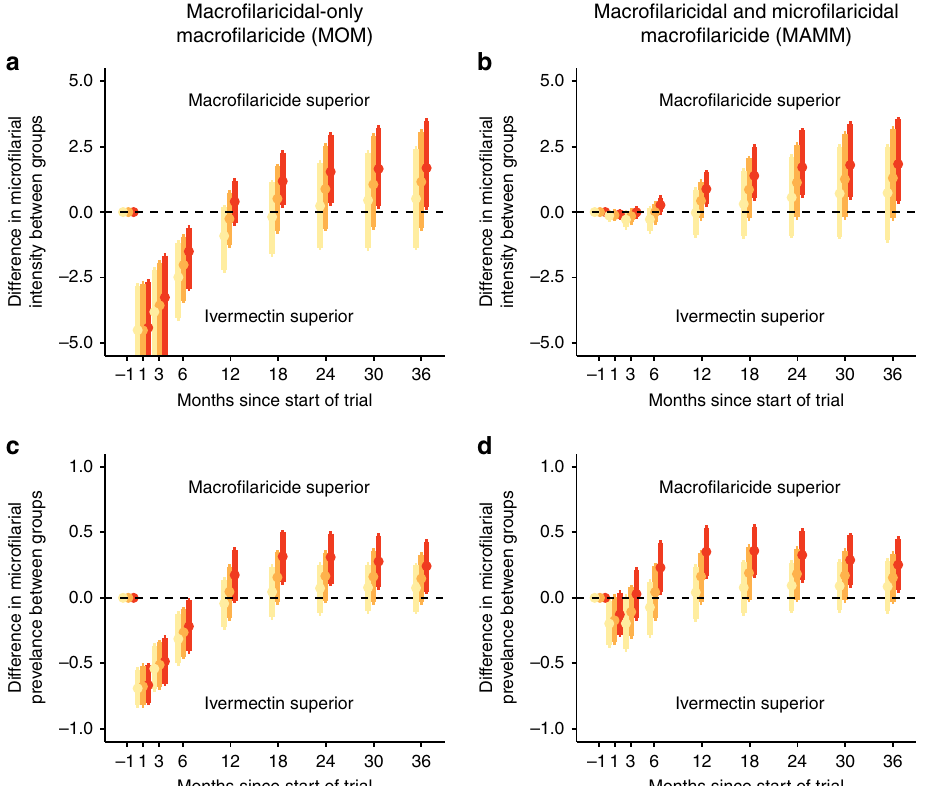
Fig. 4 Difference in parasitological outcomes between ivermectin-treated and macro fi laricide-treated participants. Each panel depicts differences in parasitological outcome measures between two 50-participant cohorts treated with either ivermectin (control group) or a hypothetical macro fi laricide (test group) in an ivermectin-naïve lower-end mesoendemic setting. The macro fi laricide has an assumed ef fi cacy of either 60% (cream points and lines), 75% (light orange points and lines) or 90% (red points and lines). Ef fi cacy refers to the percentage of adult Onchocerca volvulus killed within three months of treatment. Left-hand side panels ( a ) and ( c ) show results for a macro fi laricidal only macro fi laricide (MOM); right-hand side panels ( b ) and ( d ) show results for a macro fi laricidal and micro fi laricidal macro fi laricide (MAMM). The parasitological outcome measures compared are either the difference in arithmetic mean number of micro fi lariae (mf) per mg of skin (micro fi larial intensity, panels ( a ) and ( b )) or the difference in percentage of participants positive for mf (micro fi larial prevalence, panels ( c ) and ( d )), both measured by 2 skin snips. Participants were included in the cohort if they were positive for mf (i.e., infection status inclusion criterion was >0 mf/mg of skin). Points indicate the arithmetic mean of the simulated differences in the average response between treatment groups and vertical error bars indicate the range which captures 95% of the differences. The horizontal dashed line indicates the threshold of equivalence (i.e., difference = 0), above or below which the MOM/MAMM or ivermectin exhibit superiority,